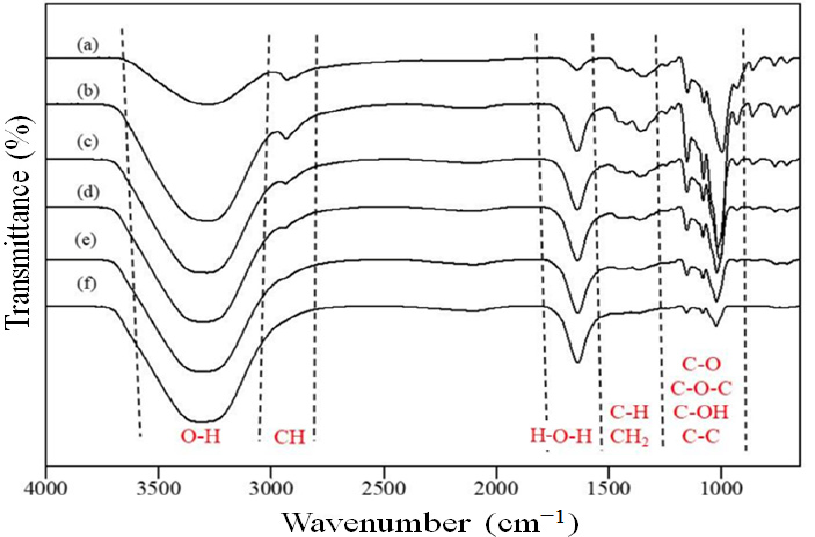
Figure 4. The FTIR spectra of starch in with the presence of different concentrations of water; (a) 0 mol, (b) 1 mol, (c) 2 mol, (d) 3 mol, (e) 4 mol and (f) 5 mol.